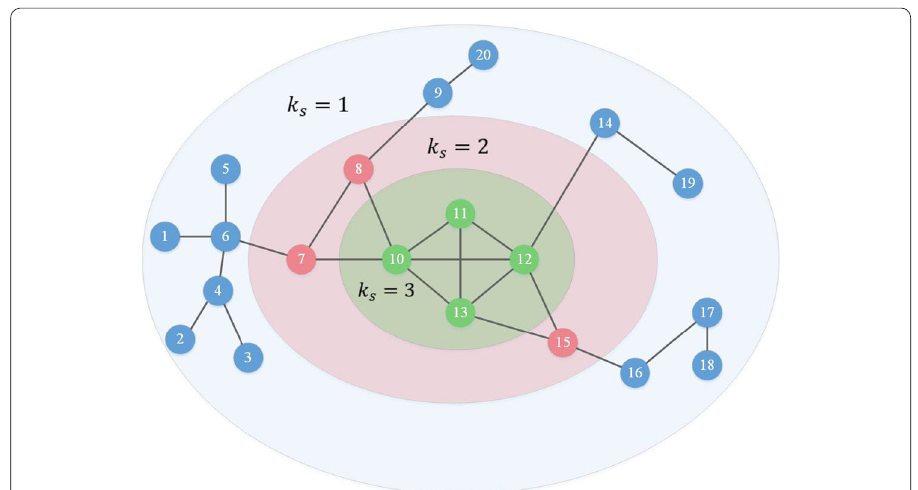
Fig. 1 Sample of decomposition by k-shell